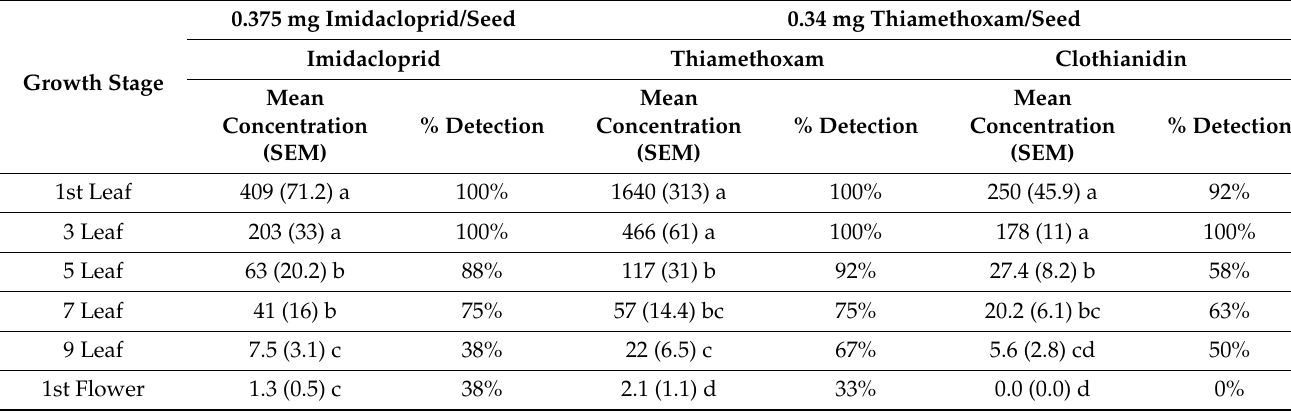
Table 2. Mean concentration (ng/g) and percent detection of neonicotinoids detected in cotton leaf tissue at each growth stage for the imidacloprid seed treatment (imidacloprid 0.375 mg/seed) and the thiamethoxam seed treatment (thi- amethoxam 0.34 mg/seed) across all